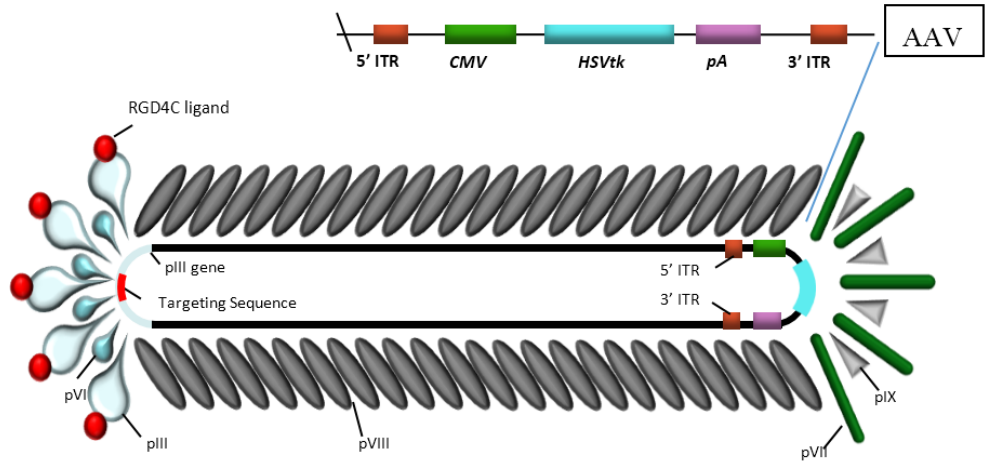
Figure 1. Structure of the hybrid vector AAV/phage (AAVP) developed by Hajitou et al. [54]. The particle contains a chimeric genome of a CMV-transgene cassette flanked by inverted terminal repeats, 3' ITR and 5' ITR, of AAV-2 and the genome of M13 filamentous bacteriophage. The outer capsid belongs to the M13 phage and hence lacks tropism for mammalian cells. The capsid contains a major coat protein pVIII and four minor coat proteins pIII, pVI on one side and pVII pIX on the other. The α v -integrin binding ligand, RGD4C, is expressed on the pIII minor coat protein of AAVP in order to allow ligand-directed targeting of the tumor vasculature and tumor